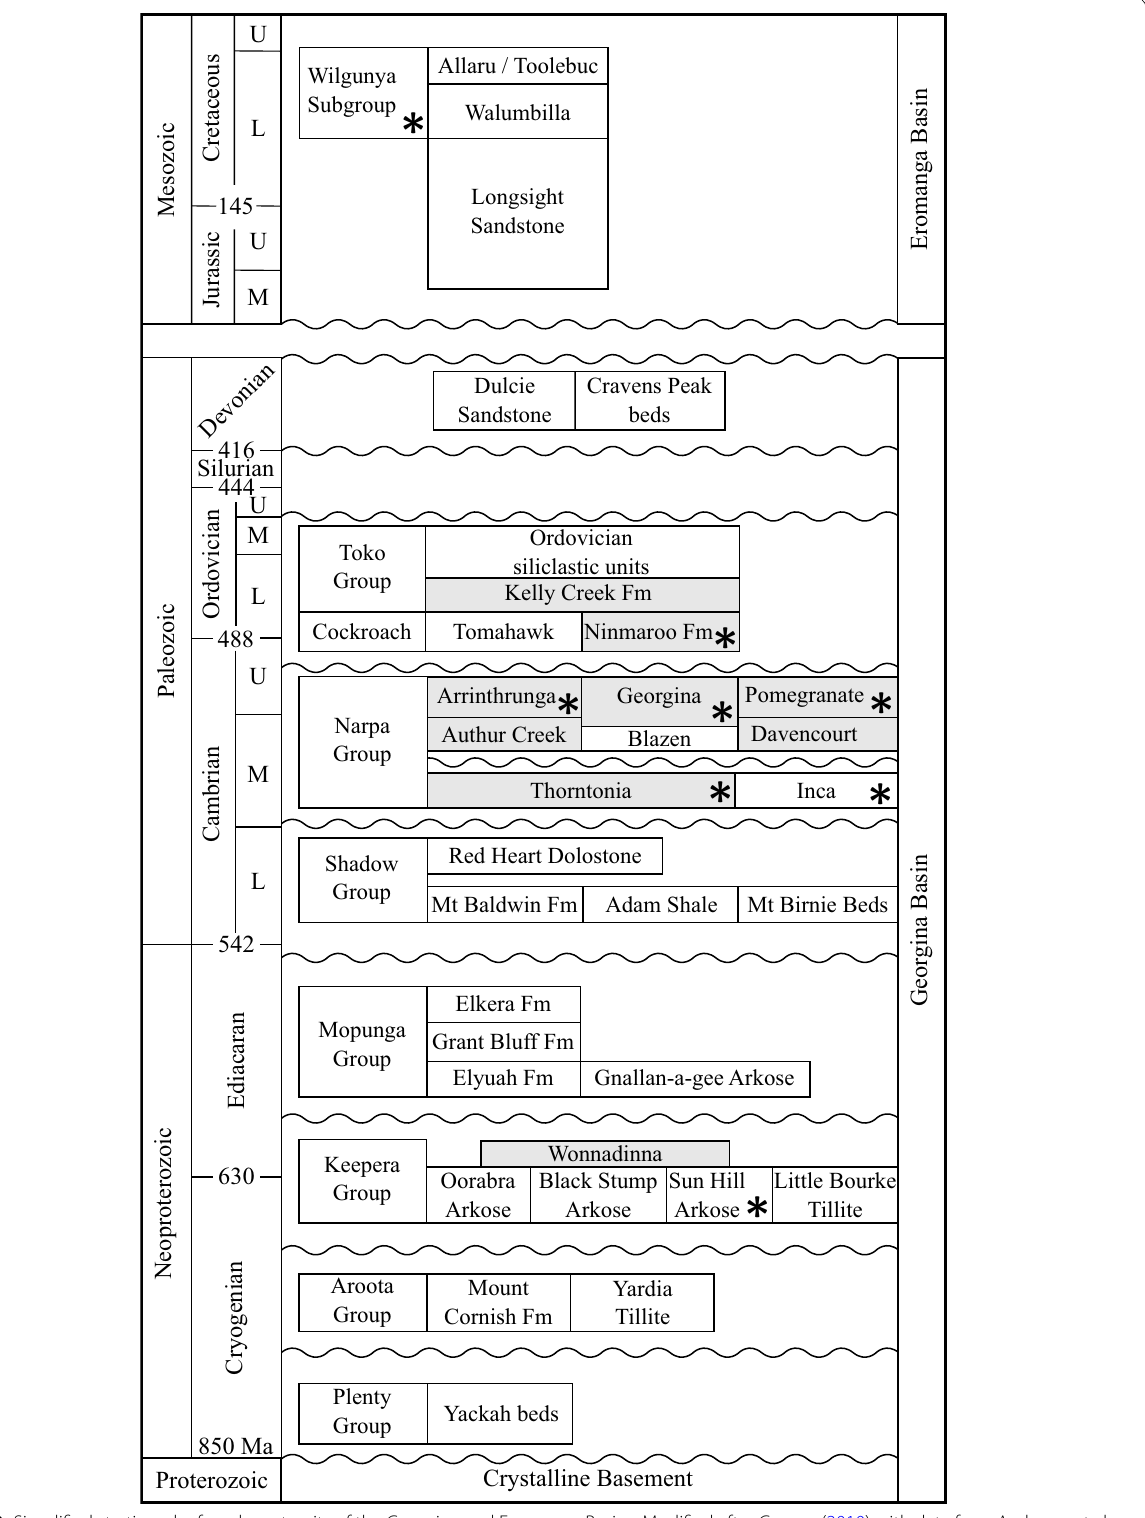
Fig. 3 Simplified stratigraphy for relevant units of the Georgina and Eromanga Basins. Modified after Greene (2010) with data from Ambrose et al. (2001), Draper (2007) and Kruse et al. (2013). Grey units are predominantly limestone, and white units are siliciclastic. Starred units intersected by boreholes Todd 1, Bradley 1 or Beantree 1 shown in Fig.